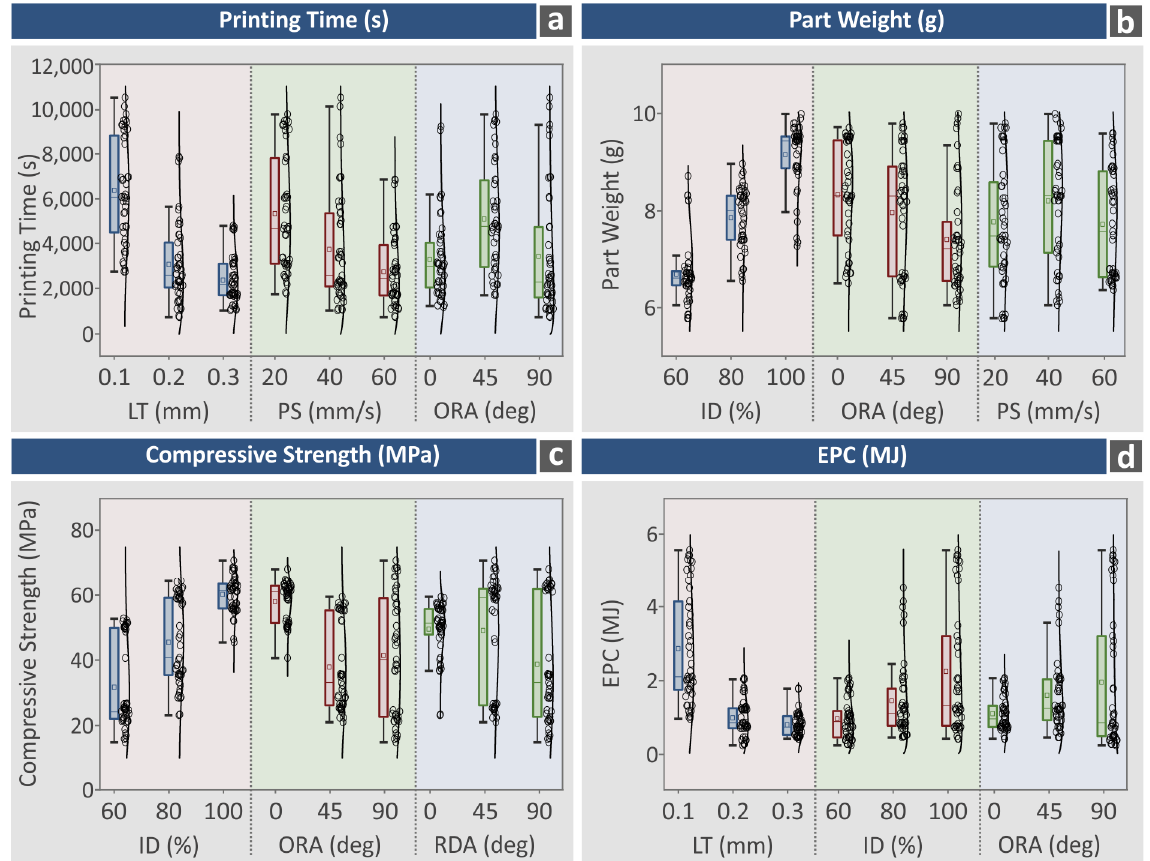
Figure 7. Box plots for ( a ) printing time (s) vs. LT (mm), PS (mm/s), and ORA (deg); ( b ) part weight (g) vs. ID (%), ORA (deg), and PS (mm/min); ( c ) compressive strength (MPa) vs. ID (%), ORA (deg), and RDA (deg); ( d ) EPC (MJ) vs. LT (mm), ID (%), and ORA (deg).